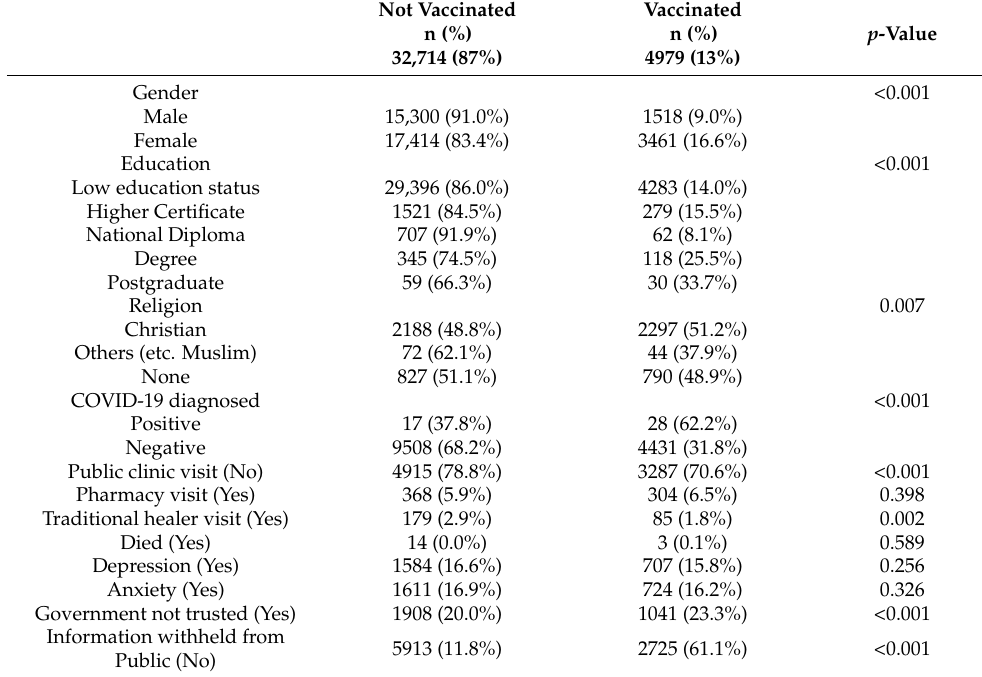
Figure 1. Percentage of people who were vaccinated and estimates of COVID-19 vaccine hesi- tancy rates. Table 1. Results about vaccination and